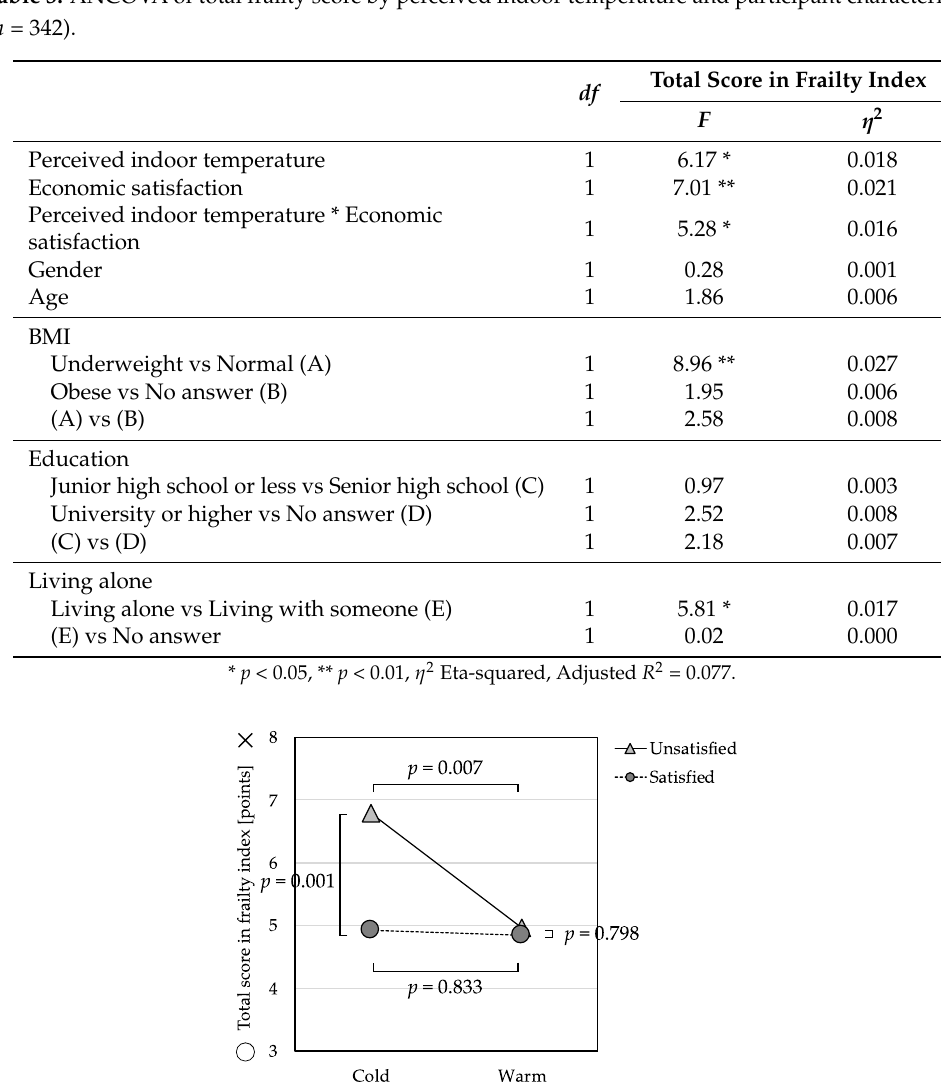
Figure 1. Interaction effect between perceived indoor temperature and economic satisfaction on the total frailty score ( n = 342). Table 4. Multivariate analysis of covariance of three subscales of the frailty index by perceived indoor temperature and participant characteristics ( n = 342).